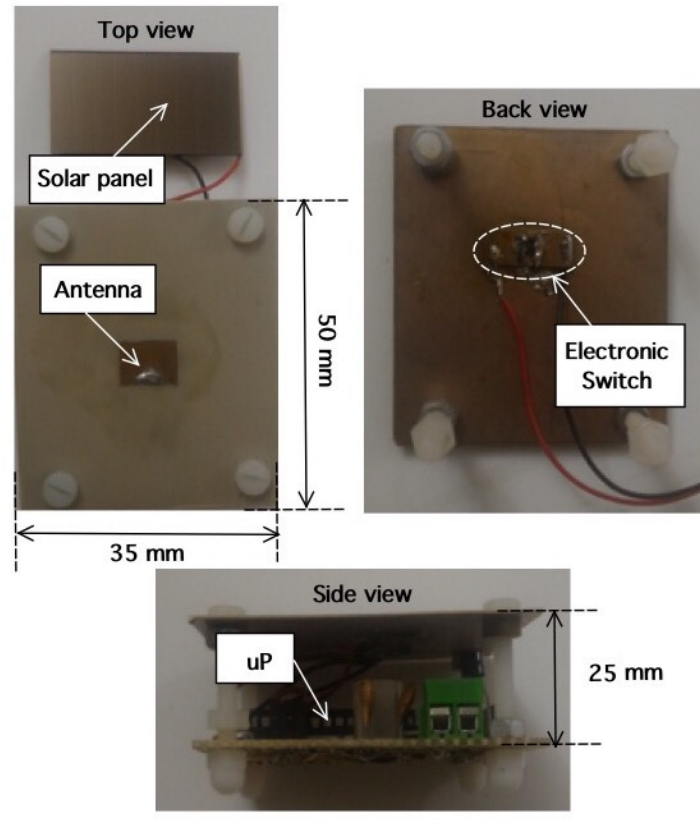
Figure 3. Photo of the MST tag equipped with temperature and humidity probes and a solar panel.